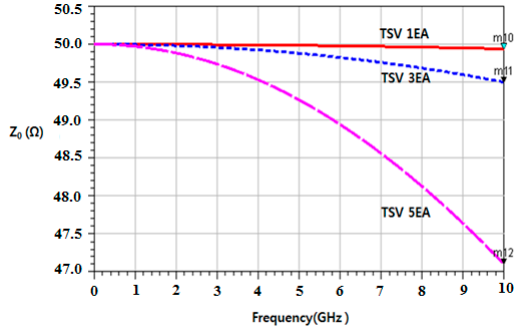
Figure 3. 1EA, 3EA, and 5EA multilayer Z 0 of Cu filled TSV.